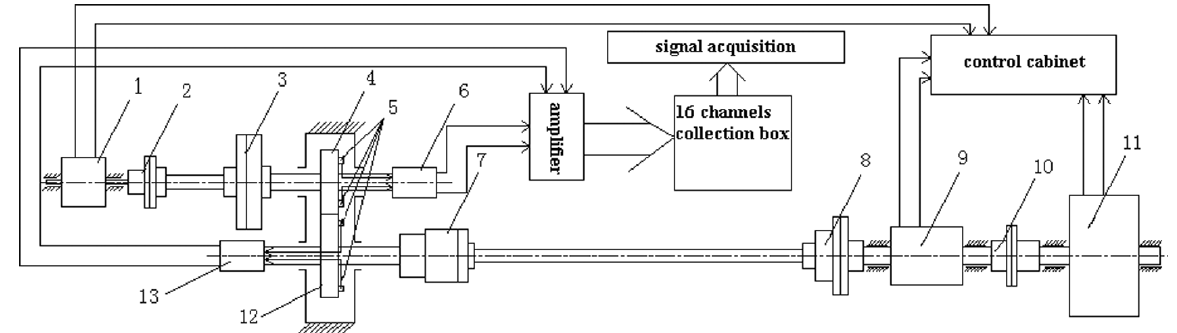
Fig. 1. The testing equipment of a fault gear system, 1. motor; 2. small coupling; 3. big coupling; 4. small gear; 5. acceleration sensor; 6. transmission ring; 7. gear coupling; 8. gear coupling; 9. torque and speed sensor; 10. coupling; 11. magnetic loader; 12. big gear; 13. transmis- sion